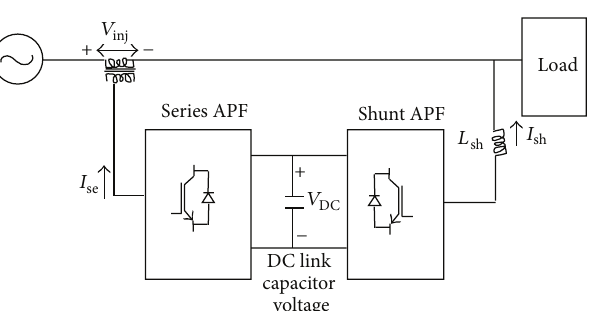
Figure 1: Schematic diagram of the